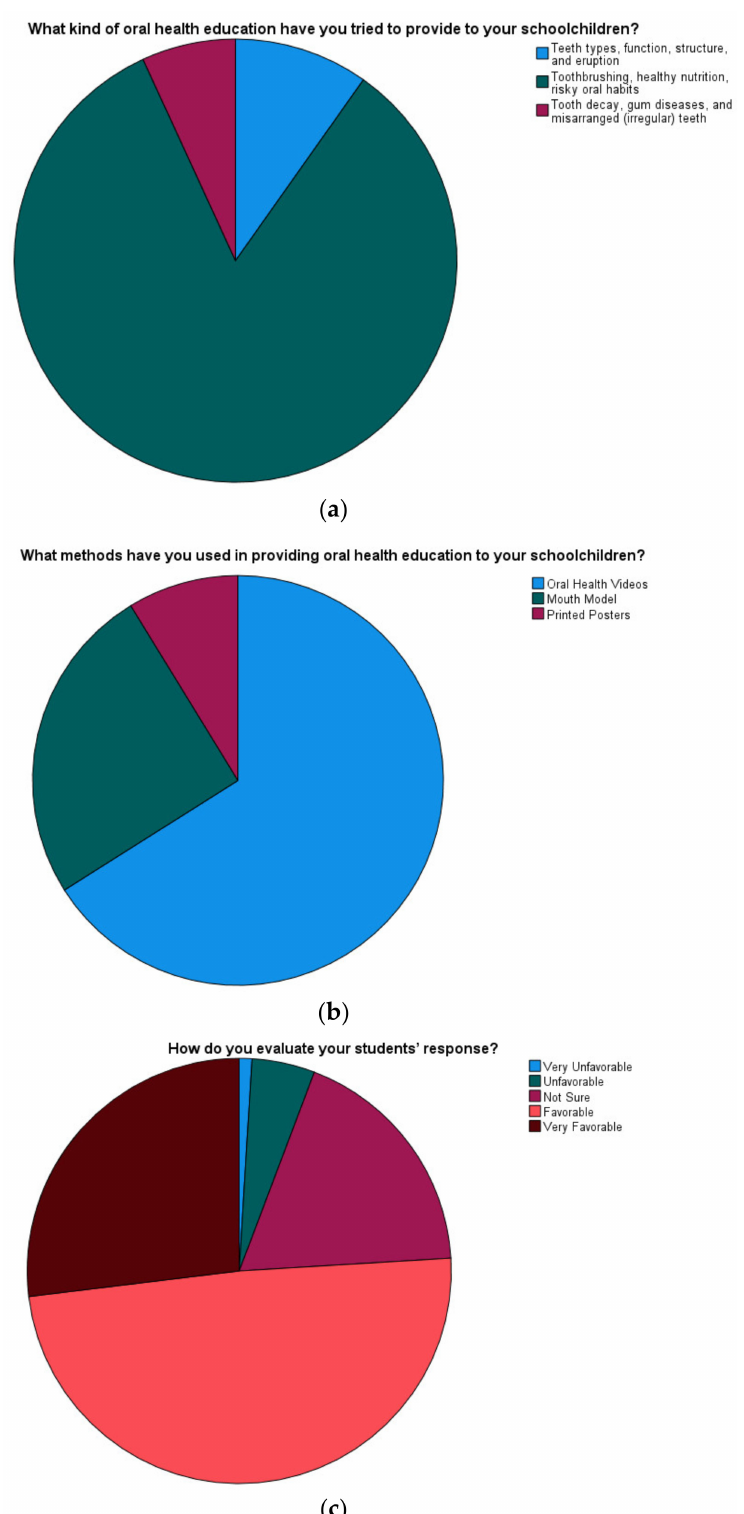
Figure 1. ( a ) Topics of oral health education provided to schoolchildren; ( b ) methods used